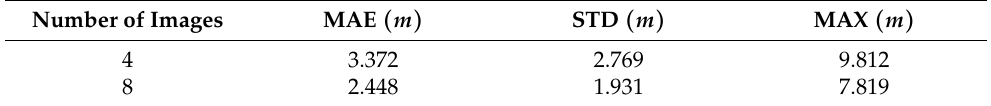
Table 2. Statistical results of altitude estimation of the target.